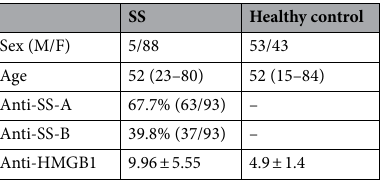
Table 1. Clinical characteristics and serum anti-HMGB1 in SS and healthy controls.